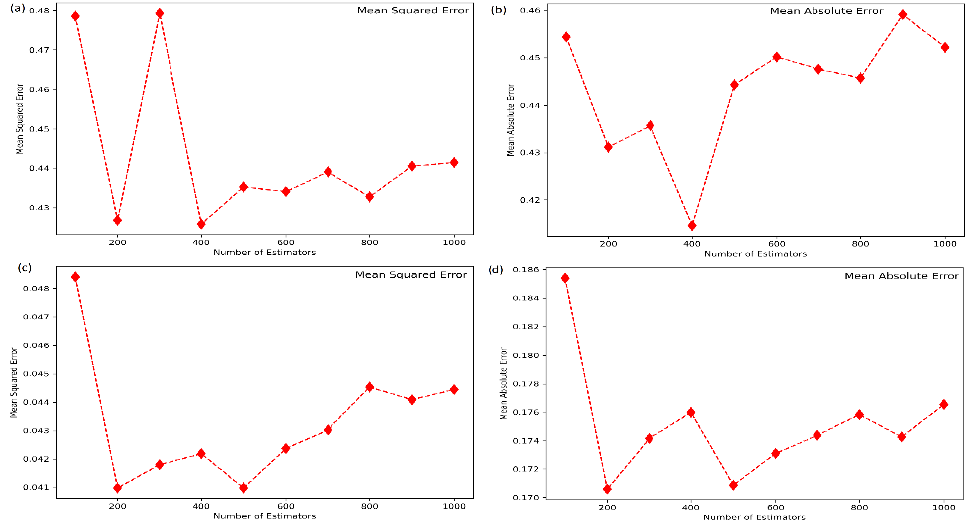
Figure 3. Effect of the number of estimators on random forest regression measured using ( a ) MSE and ( b ) MAE for Zn (g/L); as well as ( c ) MSE and ( d ) MAE for Mn (g/L).